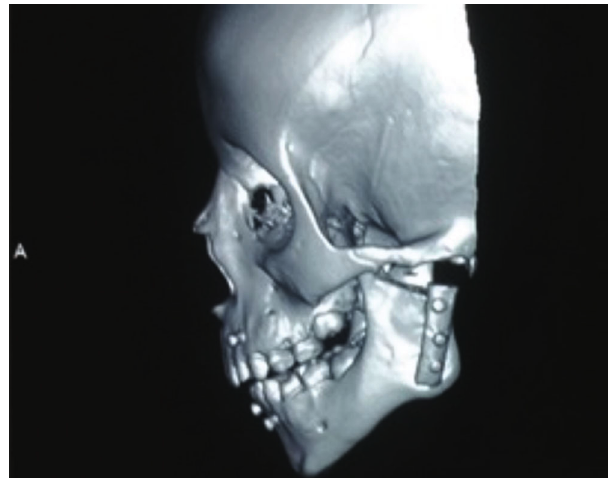
Figure 12: A post-operative 3-D reformatted image of a CT scan showing the graft in